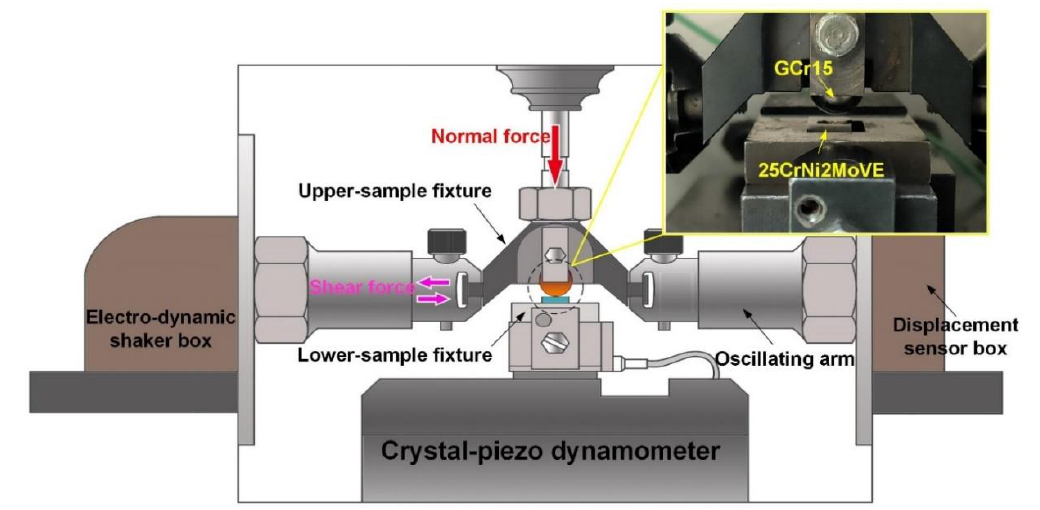
Figure 2. Schematic diagram of the test rig for fretting wear.